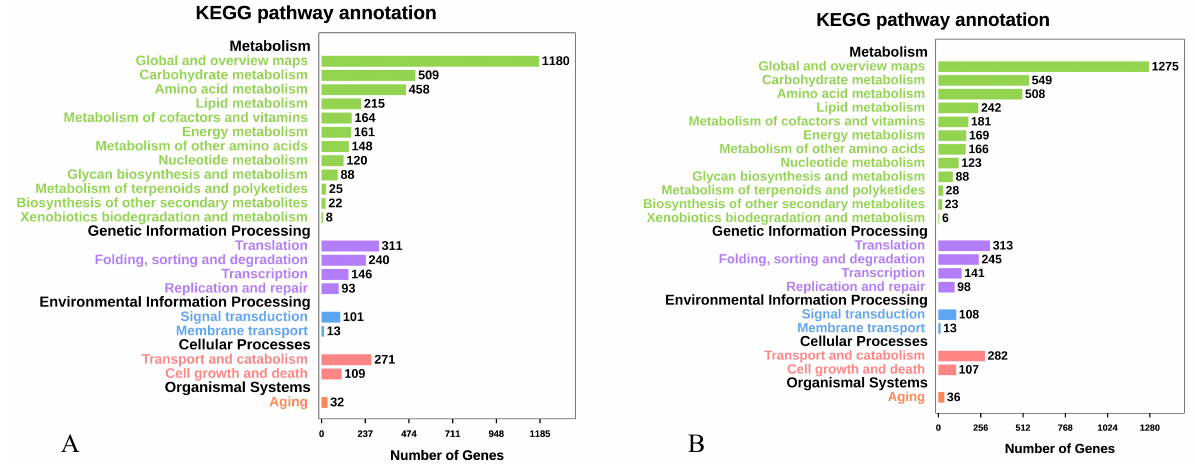
Figure 4. KEGG pathway annotation of strains QK8 ( A ) and SX13 ( B